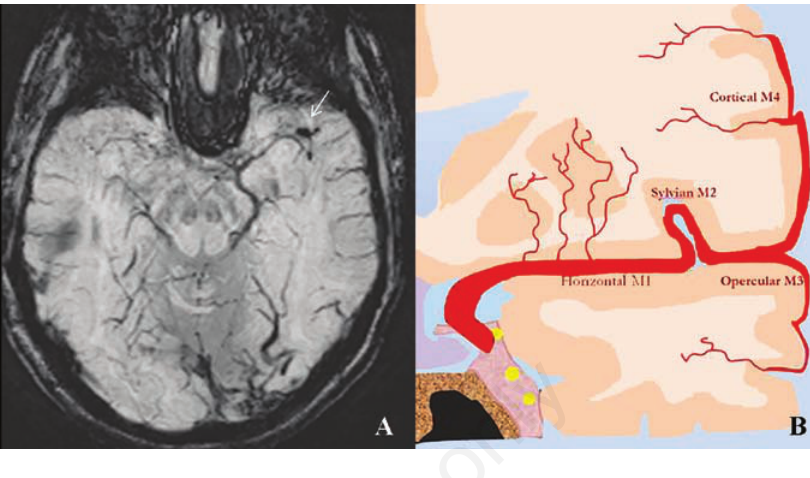
Figure 1. A) Thrombotic occlusion of the M2 division of the left MCA in a 52 year-old female presented with right-sided numbness, slurred speech. The presence of clot (arrow) is seen as hypointensity within MCA, with the diameter of the hypointense signal being larger than the diameter of adjacent and contralateral vessels. B) The four MCA segments include M1: from the origin to bifurcation, M2: from bi (tri) furcation to origin of cor- tical branches, M3: opercular branches (those within the sylvian fissure) and M4: branch- es emerging from the sylvian fissure onto the surface of the hemisphere.